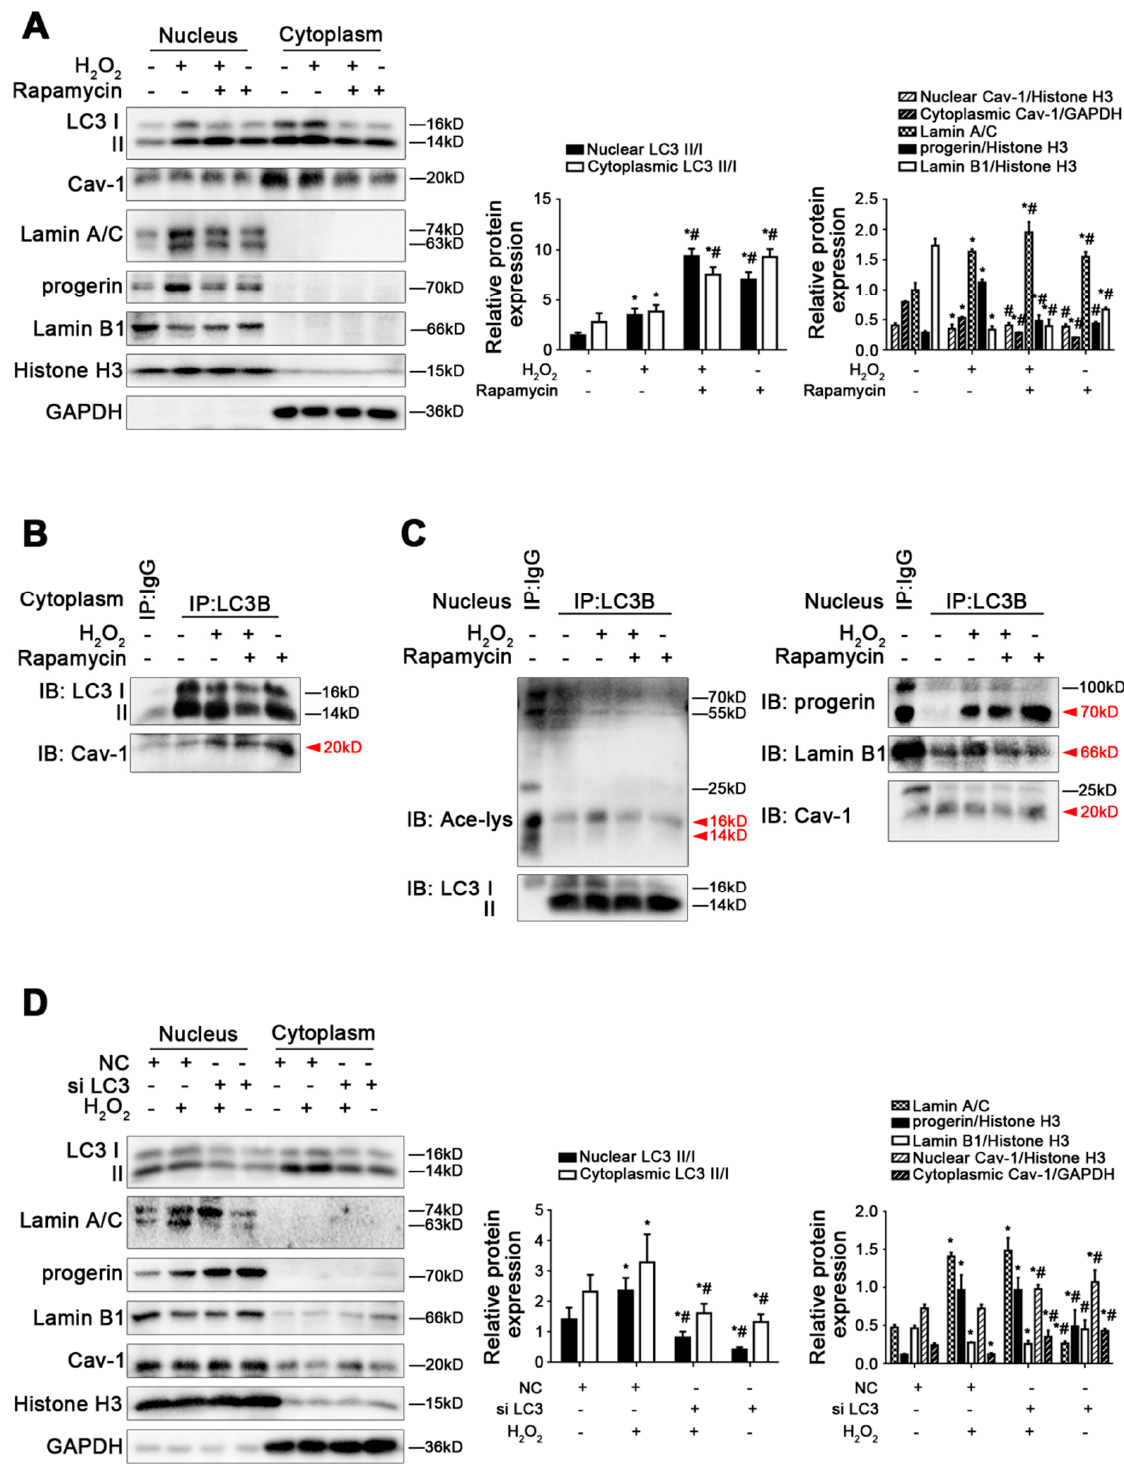
Figure 6. Excessive autophagy provokes depletion of Lamin B1 and Cav-1, as well as from progerin nucleophagic degradation. Fresh rat primary LSECs, isolated from normal male SD rats and cultured in vitro, were transfected with LC3B siRNA and nontarget siRNA (called NC) or pre-treated with rapamycin (10 nM) and then stimulated with H 2 O 2 (10 µ M) for 48 h. ( A ) Representative im- munoblots of LC3 II/I, Cav − 1, Lamin A/C, progerin, and Lamin B1 in nucleus and cytoplasm of primary LSECs in the four groups (CTR, H 2 O 2 , H 2 O 2 +rapamycin, rapamycin). The relative protein expression and LC3 II/I expression in nucleus and cytoplasm are quantified in the two graphs (right). * p < 0.05 versus the control group; # p < 0.05 versus the H 2 O 2 group. ( B ) The interaction of cytoplasmic LC3B with Cav-1 was detected by the co-IP assay. Cytoplasmic LC3B in primary LSECs was individually immunoprecipitated, and subsequently, Cav − 1 and LC3B in cytoplasm of primary